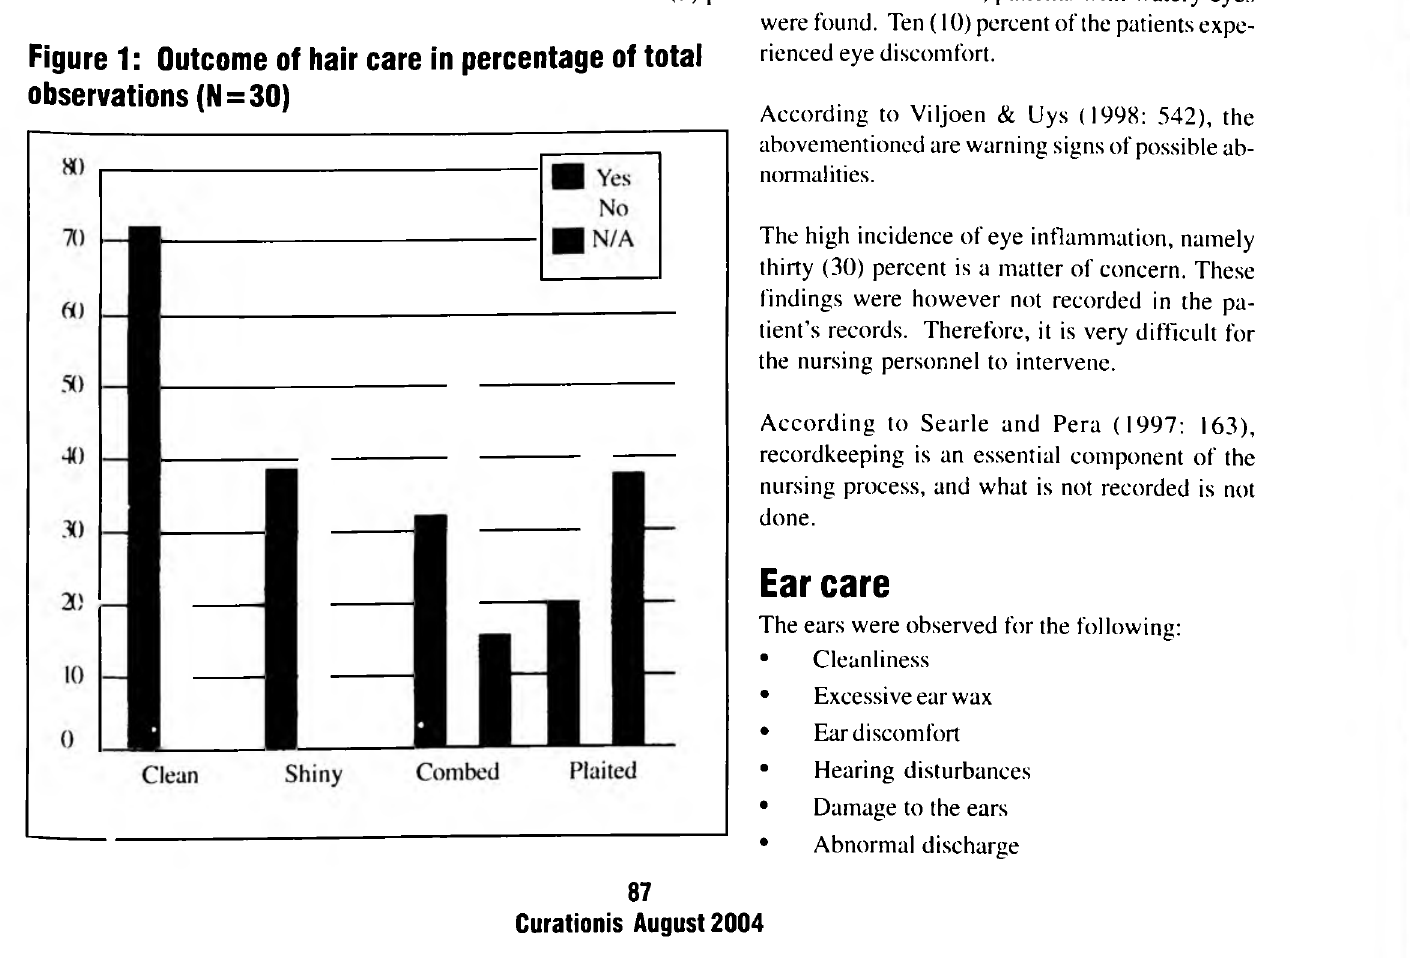
Figure 1: Outcome of hair care in percentage of total observations